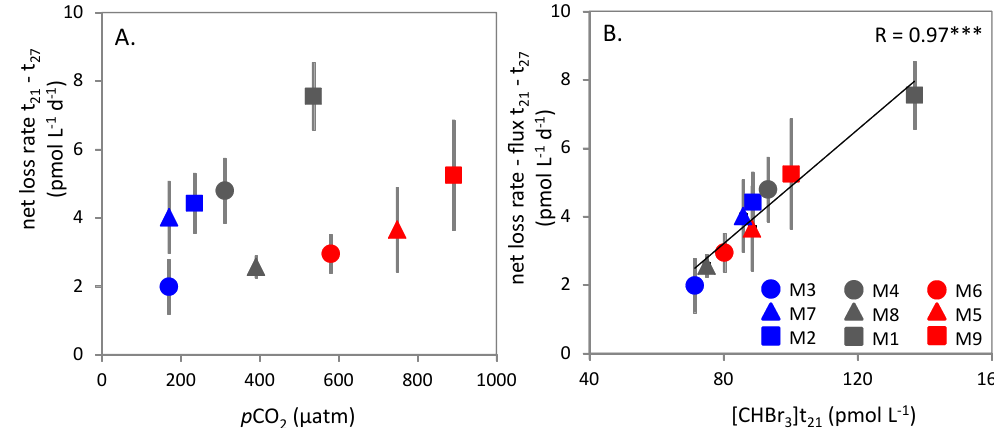
Fig. 5. Relationship between (A) net loss rates of CHBr 3 (pmold − 1 ) over the period t 21 – t 27 and mean p CO 2 (µatm), (B) net loss rates of CHBr 3 minus the sea-to-air flux (pmold − 1 ) over the period t 21 – t 27 and the concentrations of CHBr 3 on t 21 . Asterisks denote significance level of correlation ( R) : ∗∗∗ = p <